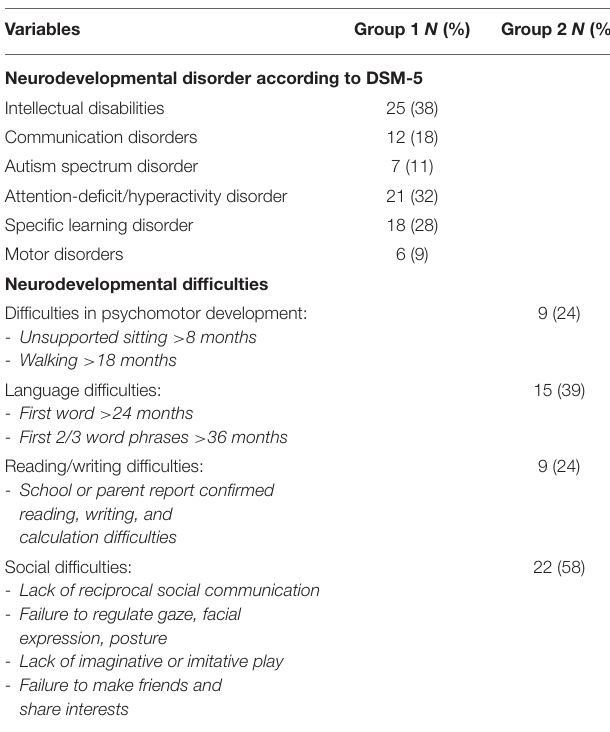
TABLE 1 | Frequency and percentage of neurodevelopmental disorder (group 1) and neurodevelopmental difficulties (group